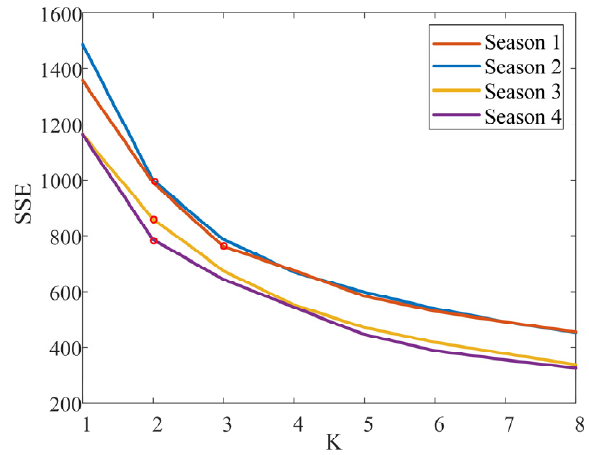
Figure 5. SSE-K curves of each season.